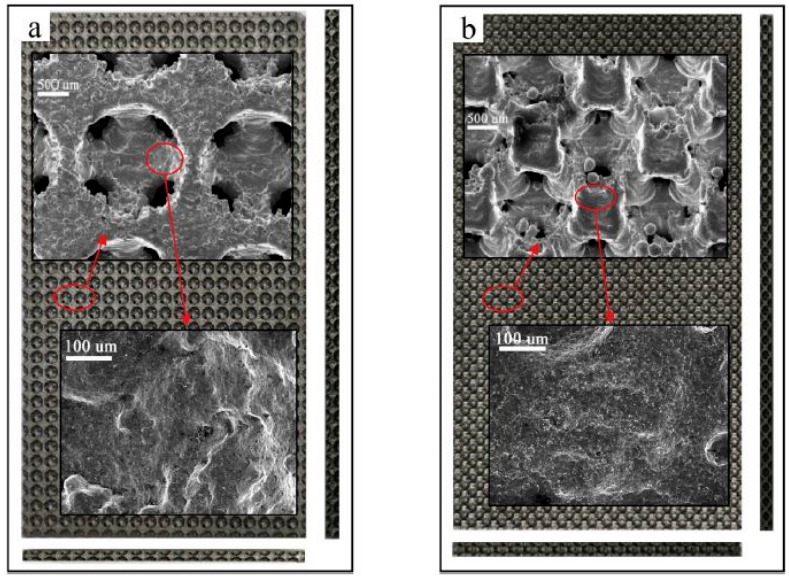
Figure 21. Optical image and SEM micrograph of 3D-printed porous stainless-steel supports with different crystal structures. ( a ) BCCs ( b ) FCCs. Reproduced with permission from [181]. Copyright Elsevier,